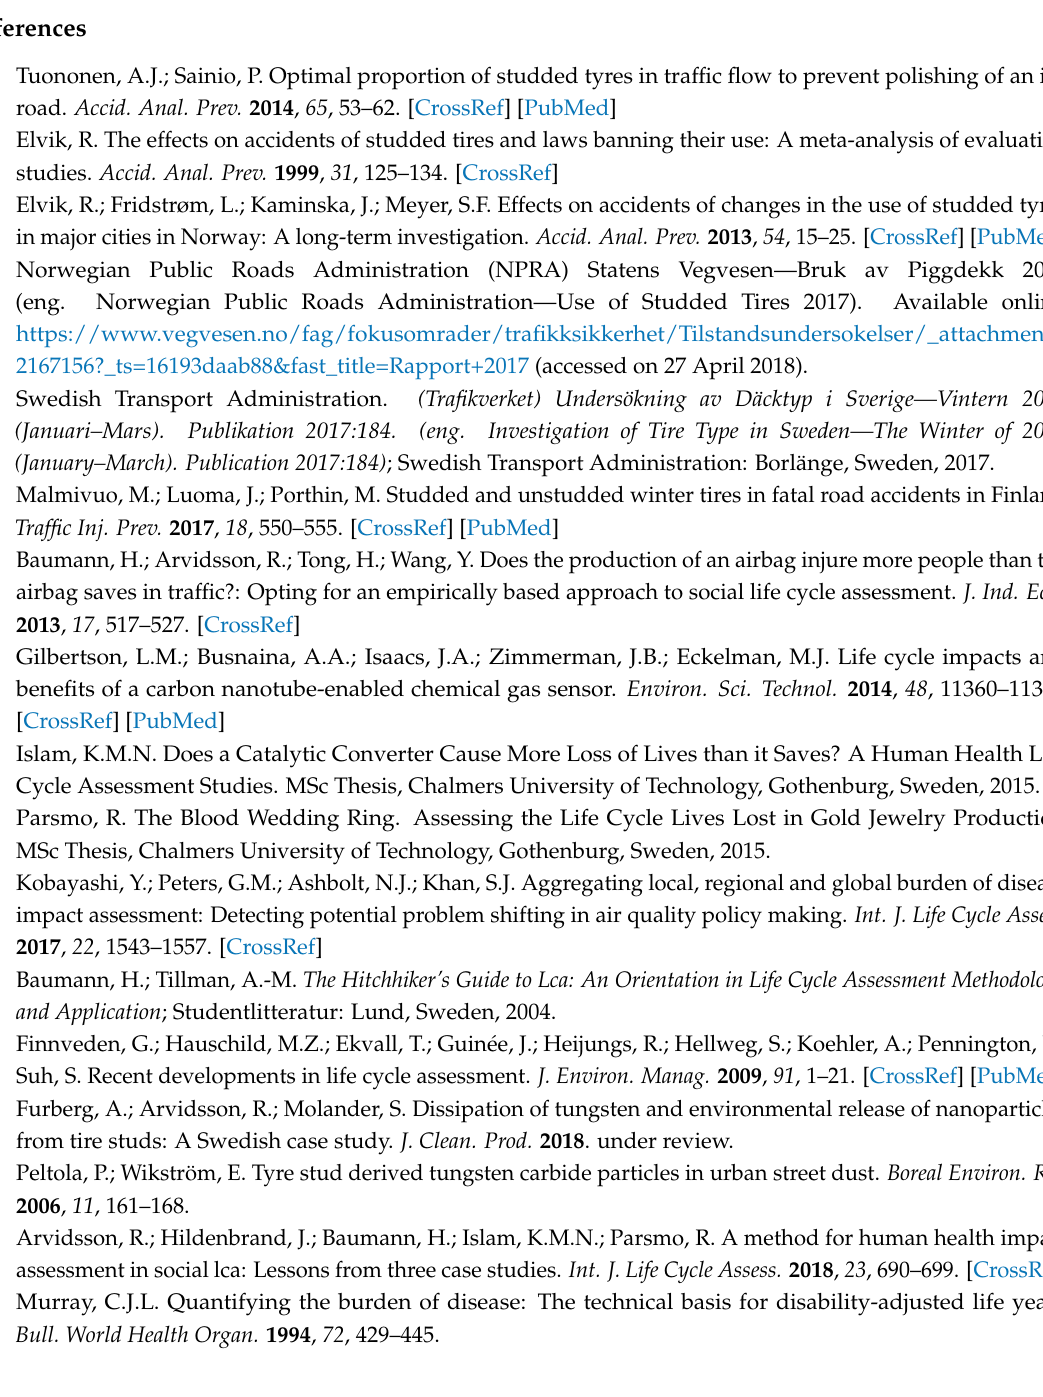
tire studs, Table S3: Ecoinvent processes and industrial categories applied for inputs and outputs in the foreground and background system, Table S4: Prices of minerals in USD/ton, Table S5: Amounts of conflict minerals mined in the Democratic Republic of the Congo, Table S6: Contributions to health